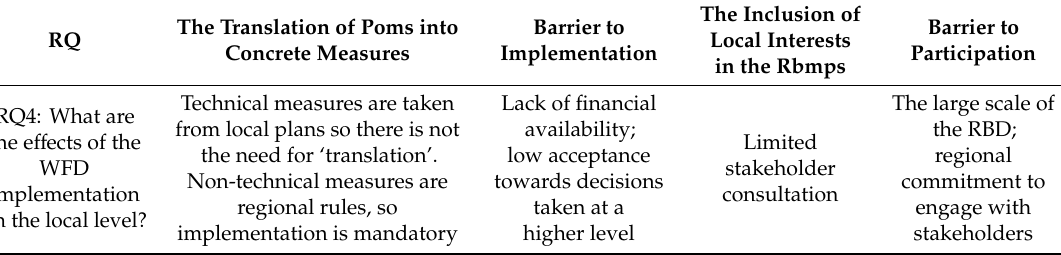
Table 3. Summary of the Results Related to the Research Question 4 Presented in Figure